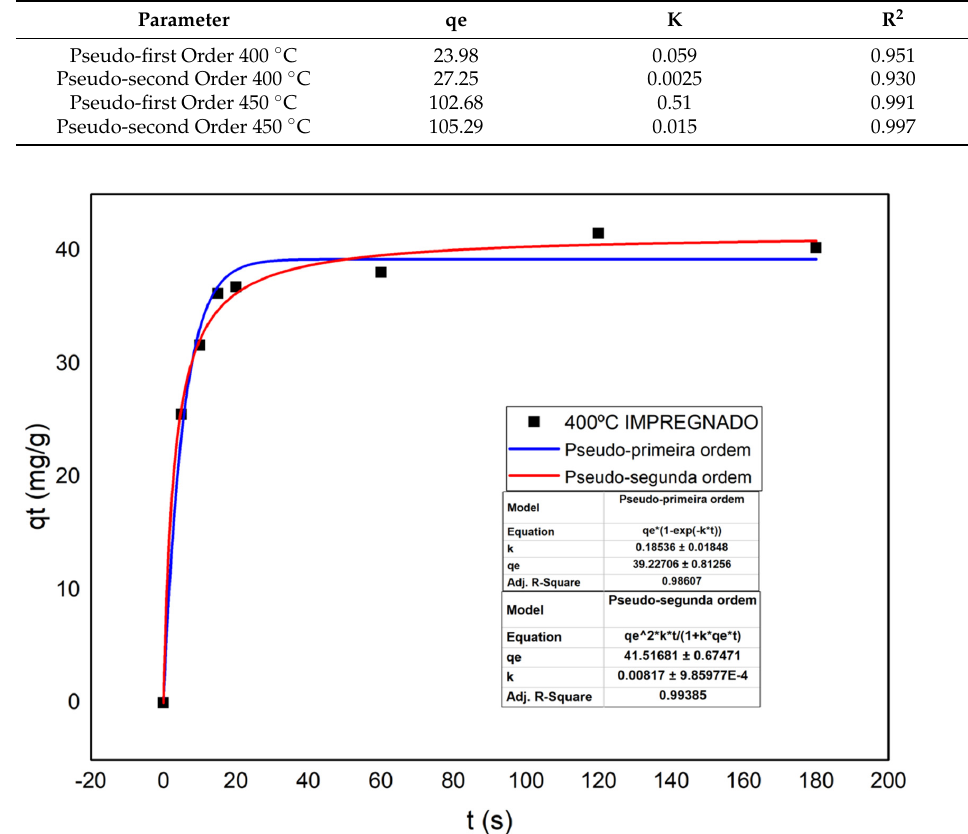
Figure 12. Pseudo-first-order and pseudo-second-order models for adsorption experiment of impregnated biochar obtained at 400 °C.